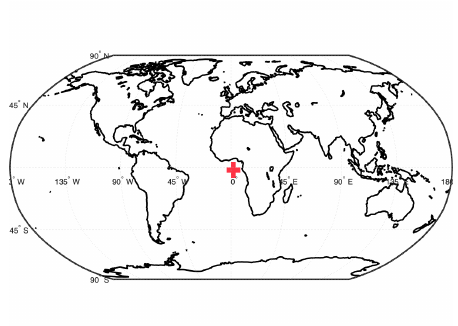
Figure 6. Observation operator across assimilation steps. A single observation (red cross) is placed during the experiments.